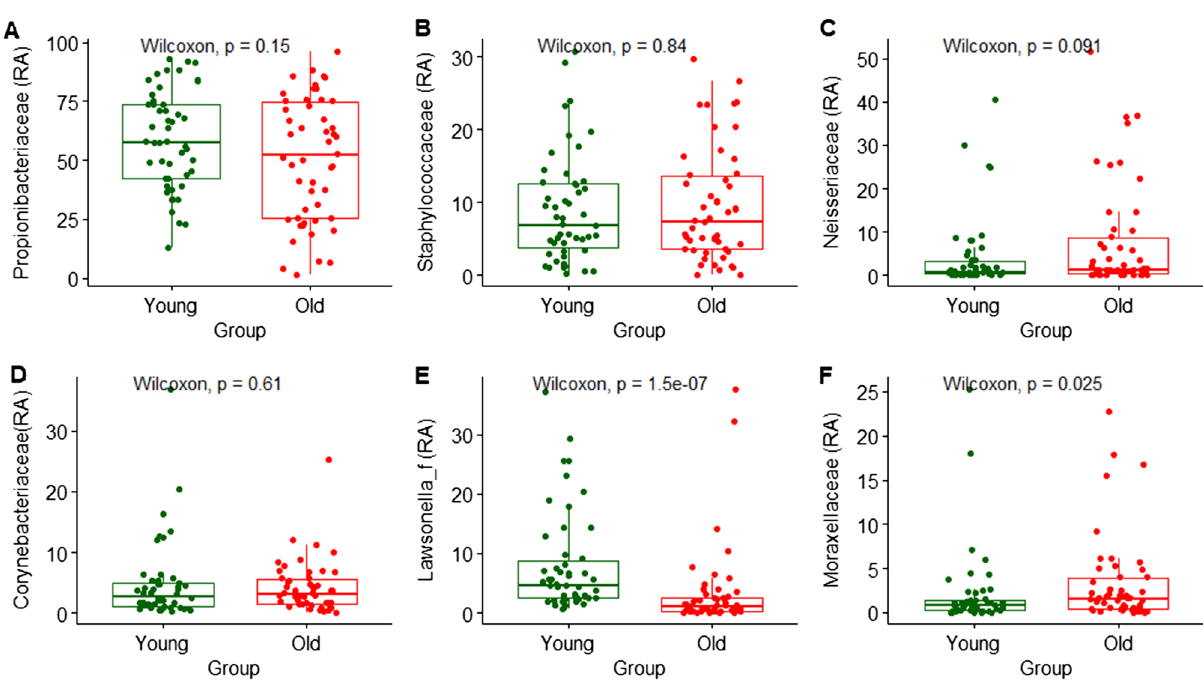
Figure 4. Relative abundance (%) of the six dominant families in skin samples between younger (young) and older (old) group. ( A ) Propionibacteriaceae; ( B ) Staphylococcaceae; ( C ) Neisseriaceae; ( D ) Corynebacteriaceae; ( E ) Lawsonella; ( F ) Morganellaceae. Wilcoxon signed-rank test was used for statistical analysis. P values are displayed in the